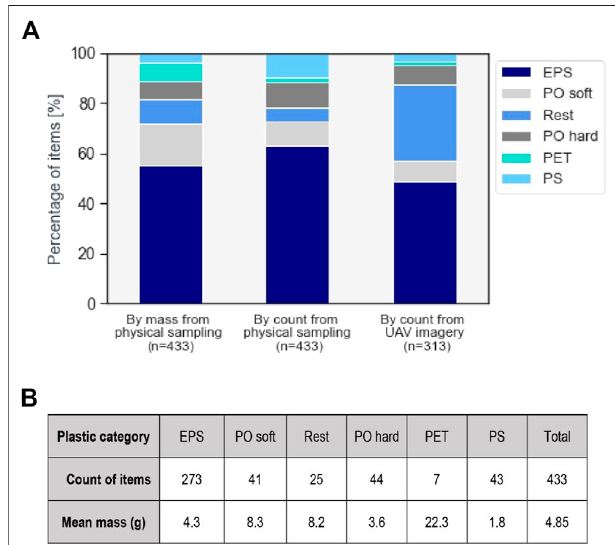
FIGURE 6 | (A) Plastic categories of observed items from physical sampling and UAV imagery analysis. Expanded polystyrene (EPS), soft polyole fi ns (PO soft), other plastics (Rest), hard polyole fi ns (PO hard), polyethylene terephthalate (PET), and polystyrene (PS). (B) Mean masses of plastic items derived from the physical sampling.